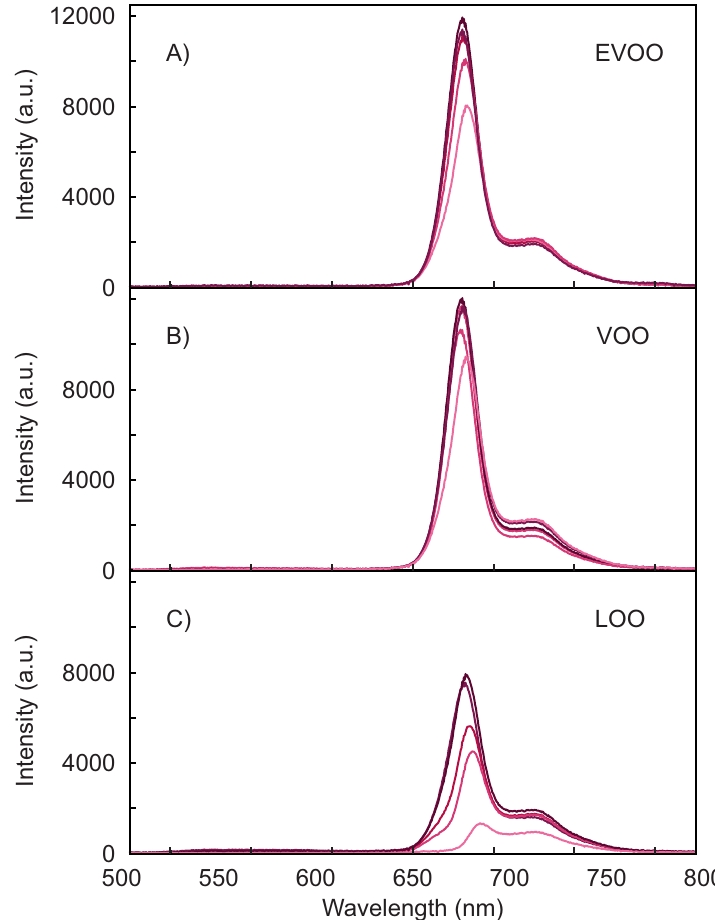
Figure 3. Fluorescence emission spectra of selected olive oils. Panel ( A ) five EVOOs, panel ( B ) five VOOs, and panel ( C ) five LOOs. Each curve shows a single spectrum without averaging or